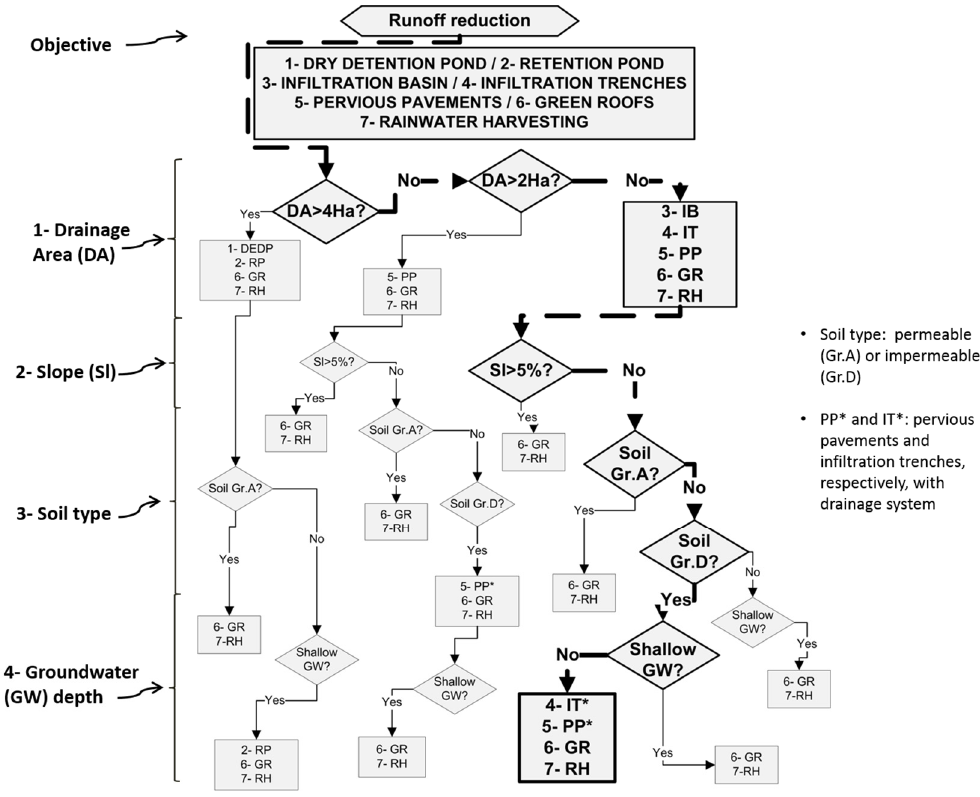
Figure 2. Decision tree for GIs selection.